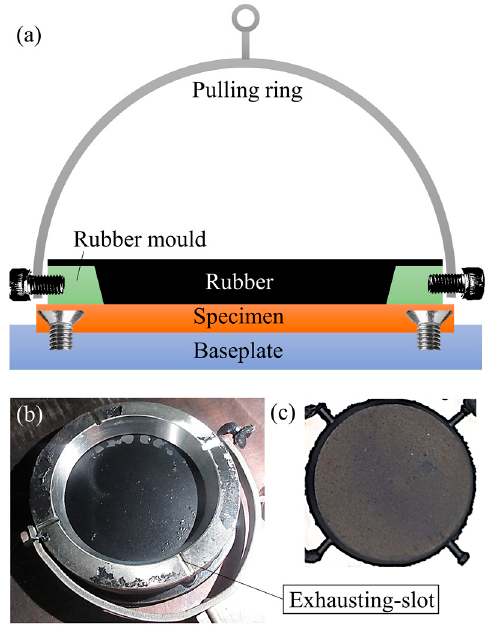
Figure 4. Schematic diagram of demolding force measurement: ( a ) assembly configuration, ( b ) photo of rubber mold, ( c ) photo of vulcanized rubber